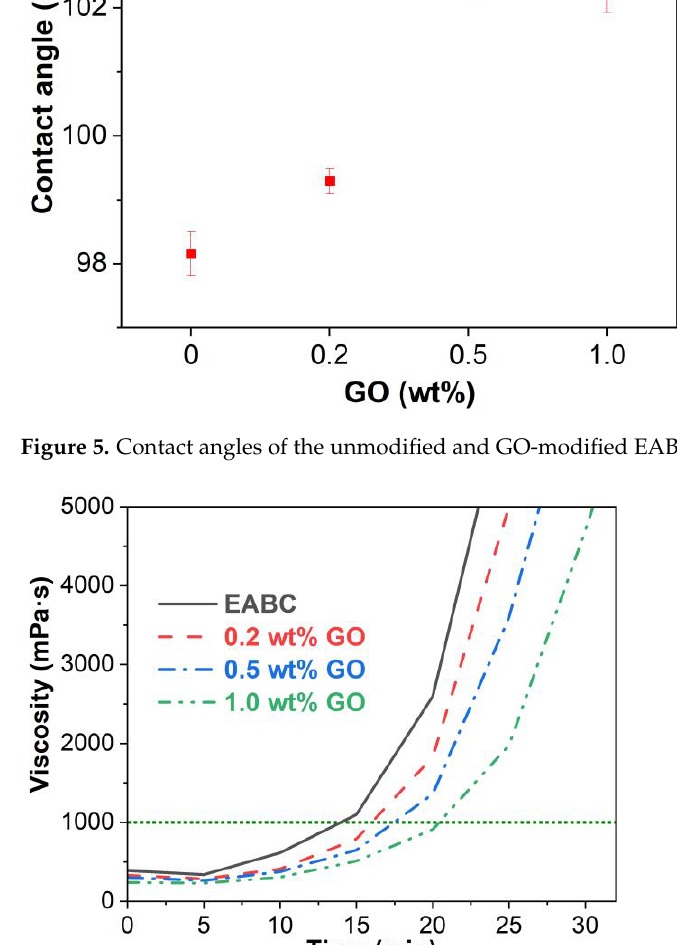
Figure 5. Contact angles of the unmodified and GO-modified EABCs.